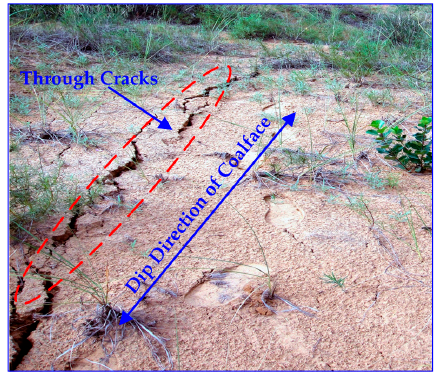
Figure 10. Through cracks in the surface.